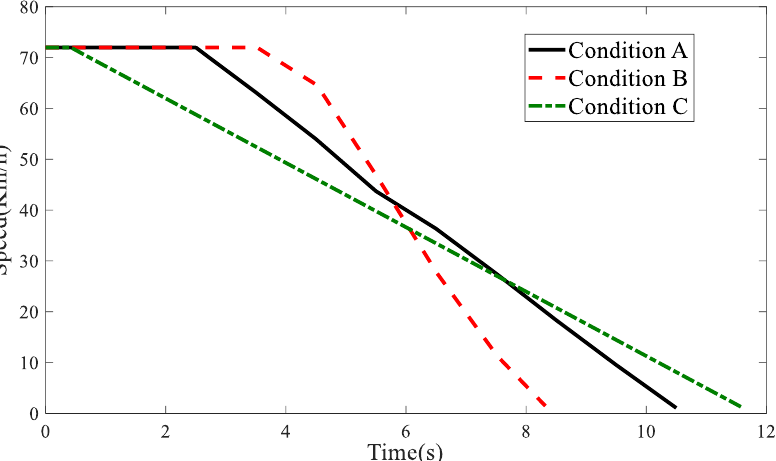
Figure 17. Vehicle speed with time under different conditions.